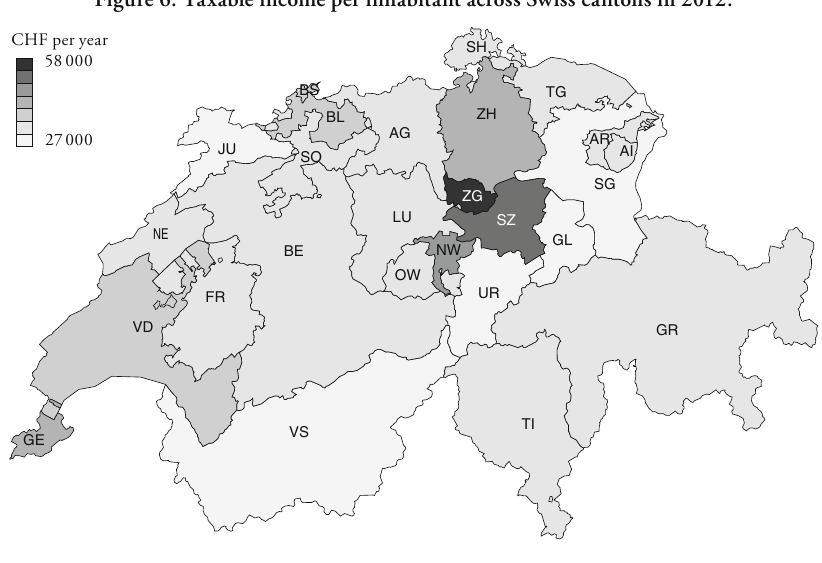
Figure 6: Taxable income per inhabitant across Swiss cantons in 2012.